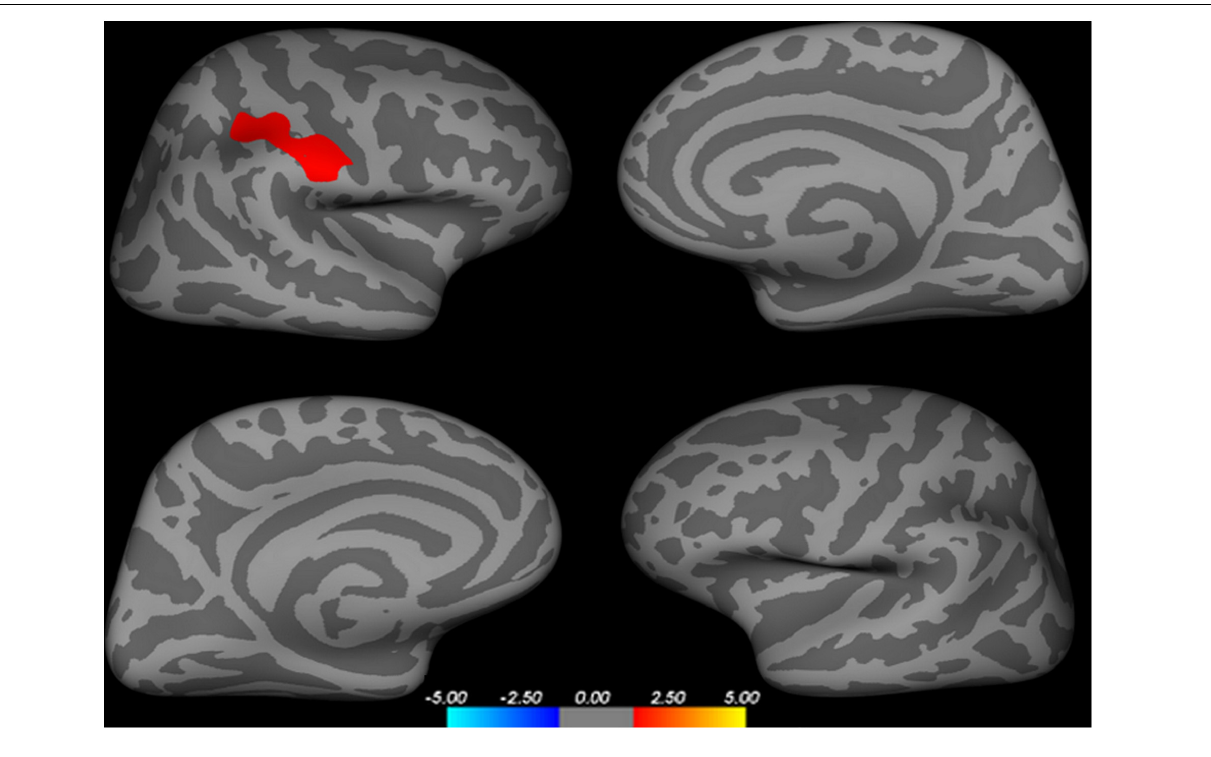
FIGURE 1 | Regions with increased cortex thickness in AMD group.